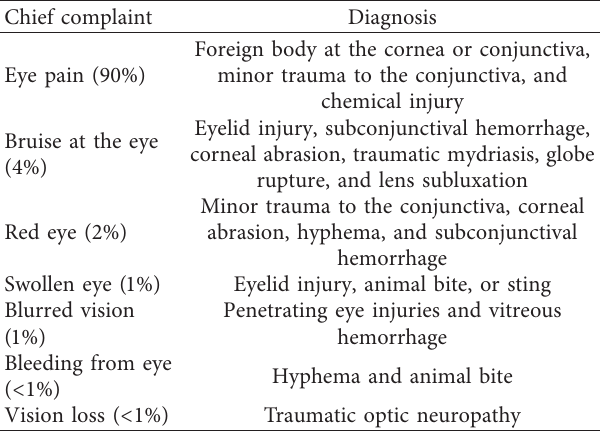
Table 4: Diagnosis of traumatic eye disease classified by the chief complaint.